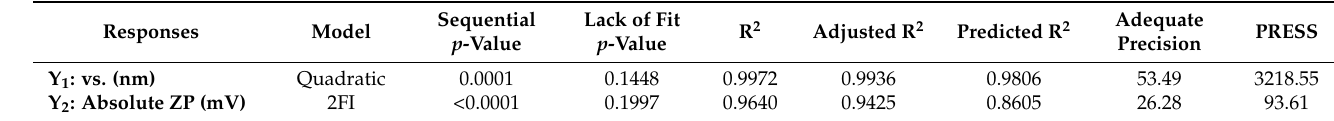
Table 1. Fit statistics of EGA-EML-APA responses according to the best fitting